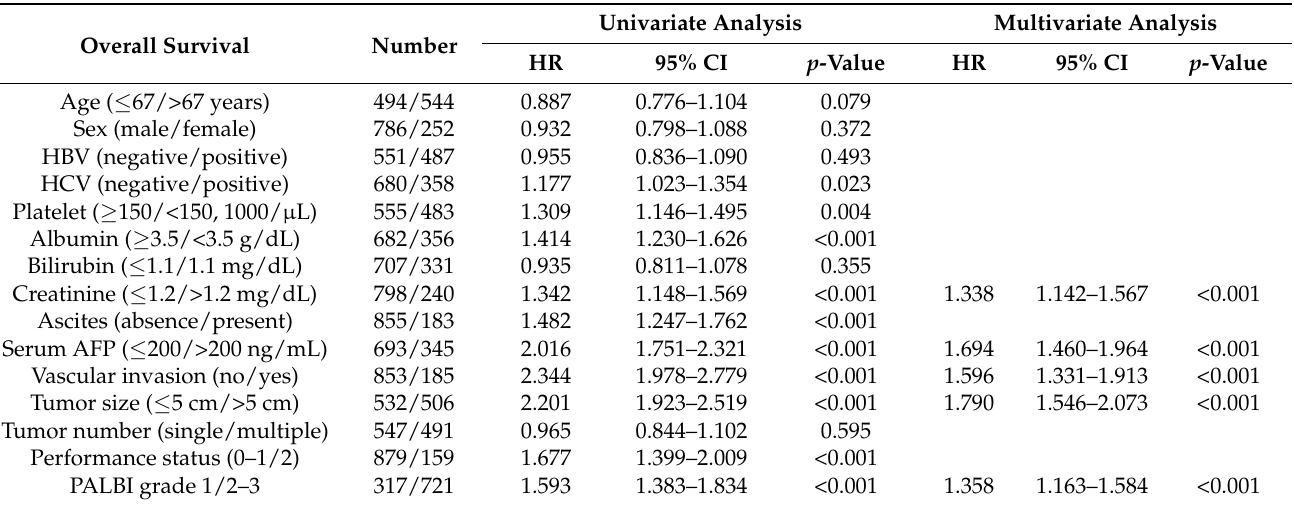
Table 5. Multivariate analysis of overall survival in patients undergoing transarterial chemoemboliza- tion including PALBI grade.